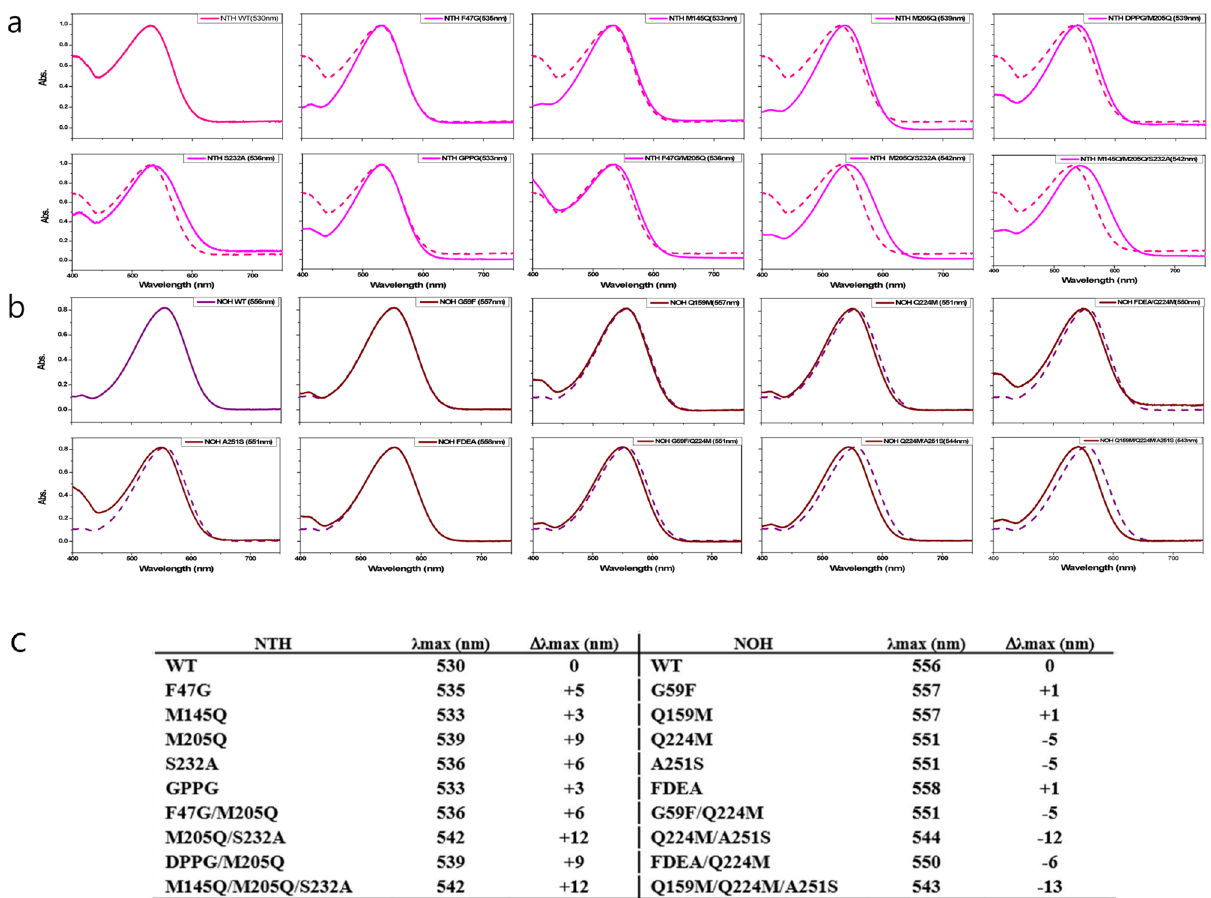
Figure 4. Absorption spectrum of N-terminal His-tagged Thermococcus heliorhodopsin (NTH) and N-terminal His-tagged Ornithinimicrobium heliorhodopsin (NOH). ( a ) The maximum absorption of WT and mutant NTH is between 530 and 542 nm. The double mutant (M205Q/S232A) showed a large shift to red (12 nm). The WT NTH absorption spectrum is shown as a dotted-line in the mutant absorption spectrum. ( b ) The maximum absorption of WT and mutant NOH is between 543 and 556 nm. The double mutant (Q224M/ A251S) showed a large shift to blue (12 nm). The WT NOH absorption spectrum is shown as a dotted-line in the mutant absorption spectrum. ( c ) Table of λmax values for each WT and mutant